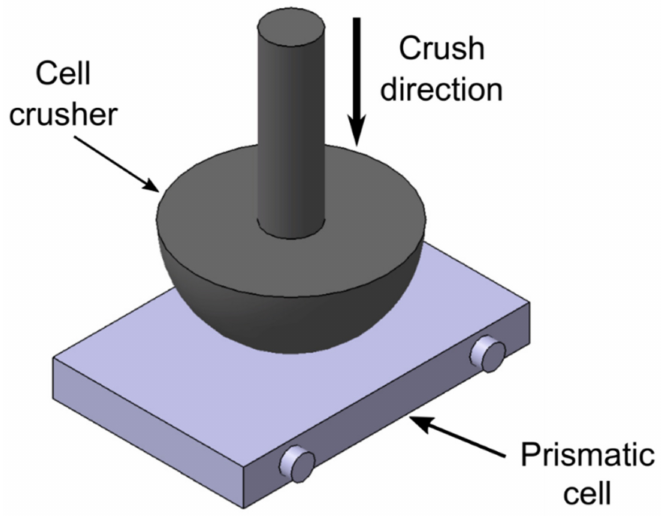
Figure 9. Cell crusher for prismatic cells as per IEC 62660-2:2010